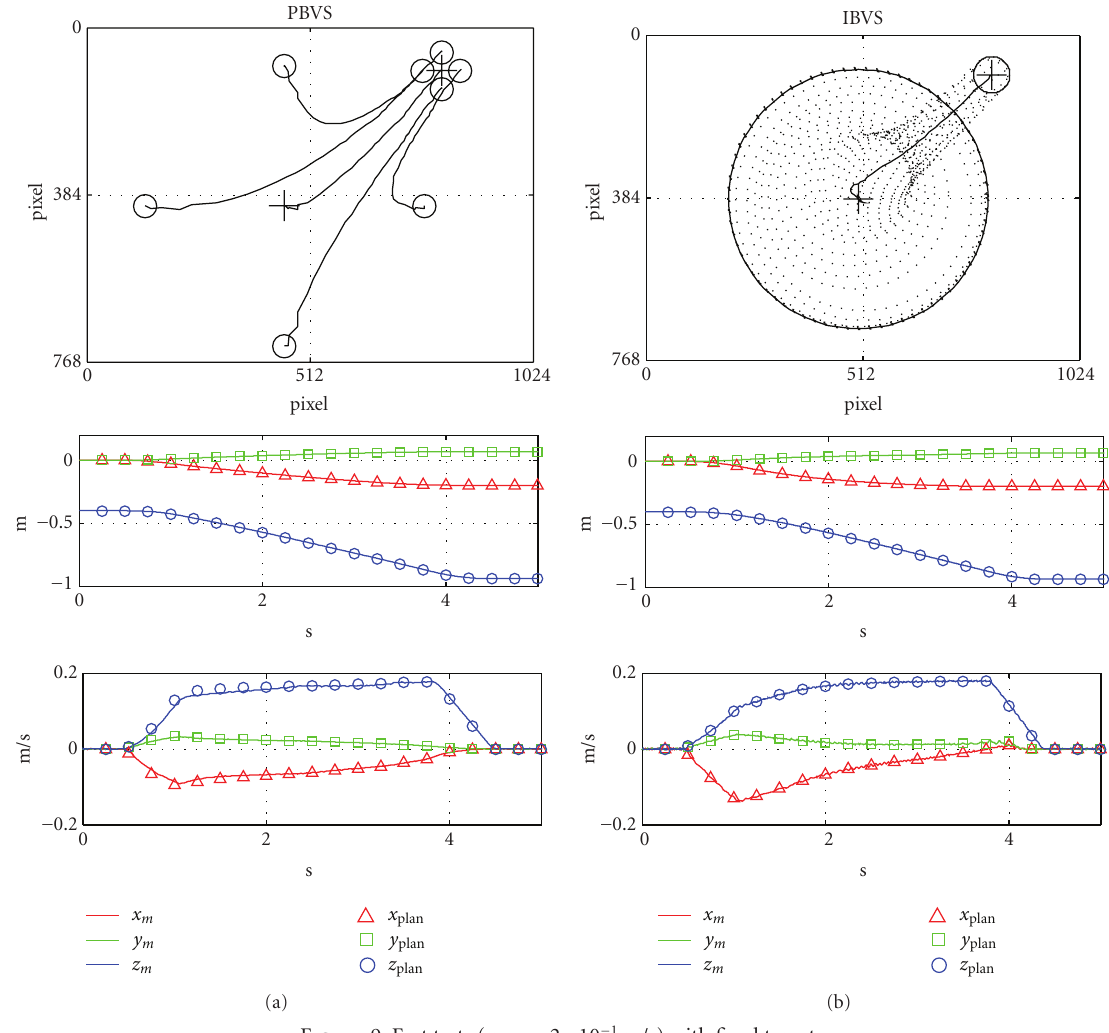
Figure 9: Fast tests ( v max = 2 · 10 − 1 m/s) with fixed